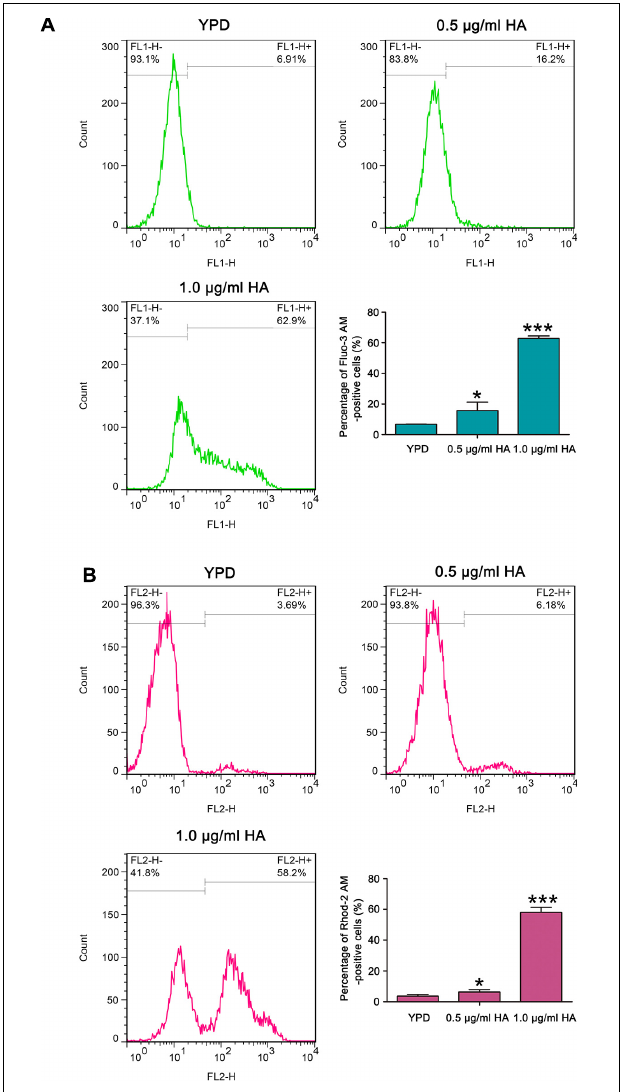
FIGURE 6 | Calcium levels were assessed in the cytosol and mitochondria after HA treatment. (A) Cytosolic calcium contents were examined by flow cytometry via Fluo-3 AM staining. The percentage of Fluo-3 AM-positive cells were shown in the histogram, and data were shown as mean ± SD ( n = 3). ∗ P < 0.05 and ∗∗∗ P < 0.001. (B) Mitochondrial calcium level was evaluated using Rhod-2 AM staining. The histogram was the quantitative analysis of the percentage of Rhod-2 AM-positive cells, and the data were expressed as mean ± SD ( n = 3). ∗ P < 0.05 and ∗∗∗ P <